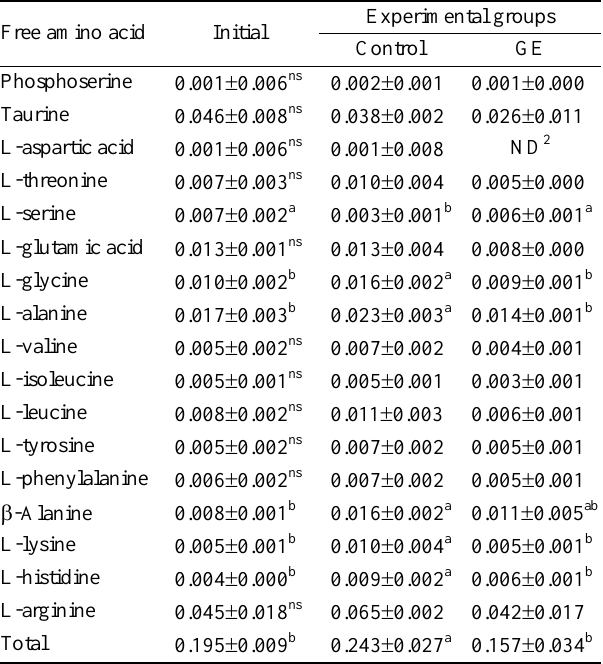
Table 2. Free amino acid composition (mg/100 mg, as-is basis) in whole body of juvenile sterlet sturgeon fed diets for 5 wks 1 Free amino acid